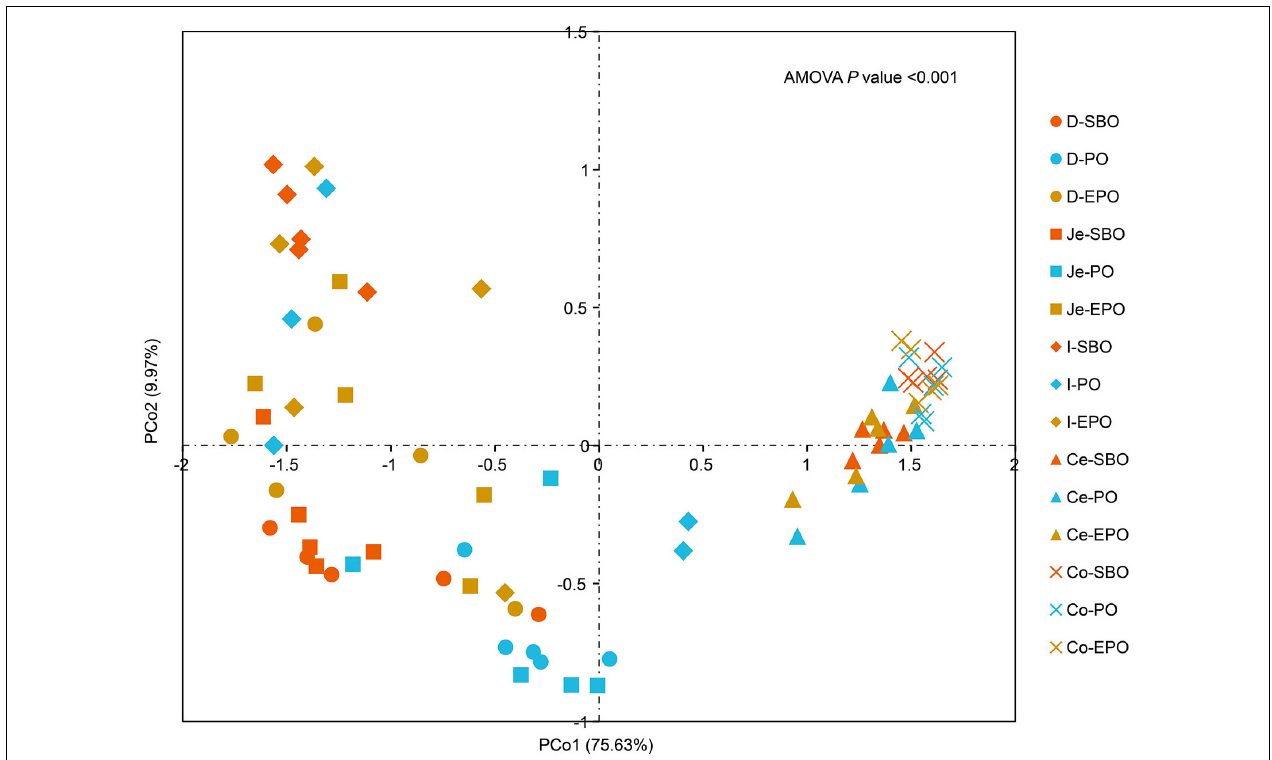
FIGURE 2 | Principle coordinate analysis (PCoA) of gut microbiota in the SBO, PO, and EPO groups by unweighted UniFrac distance ( n = 5 per group). The percentage of variation explained by PCo1 and PCo2 are indicated in the axis. Abbreviation: D-, duodenum-; Je-, jejunum-; I-, ileum; Ce-, cecum-; Co-, colon; SBO, soybean oil; PO, palm oil; EPO, encapsulated palm